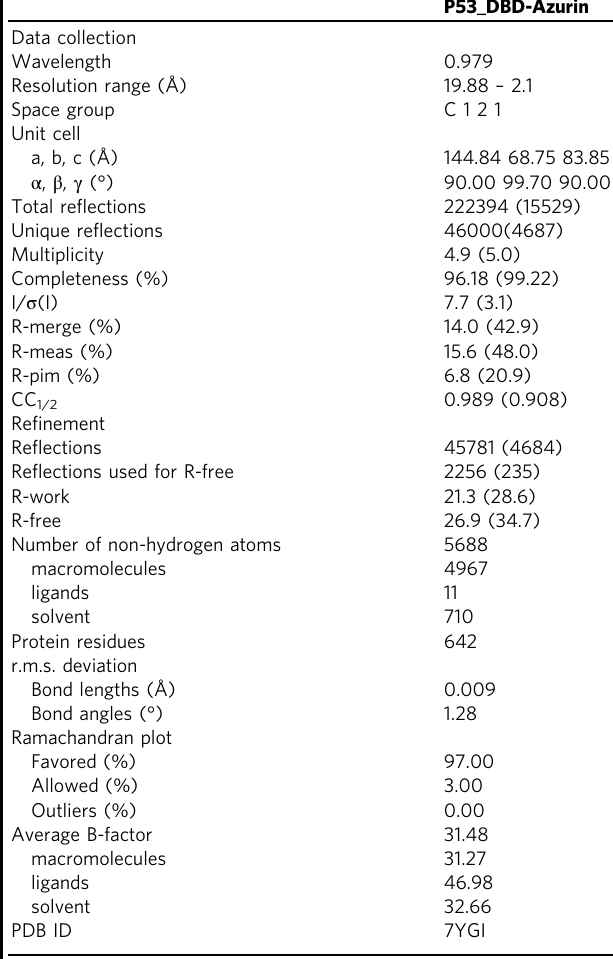
Table 1 Data collection and re fi nement